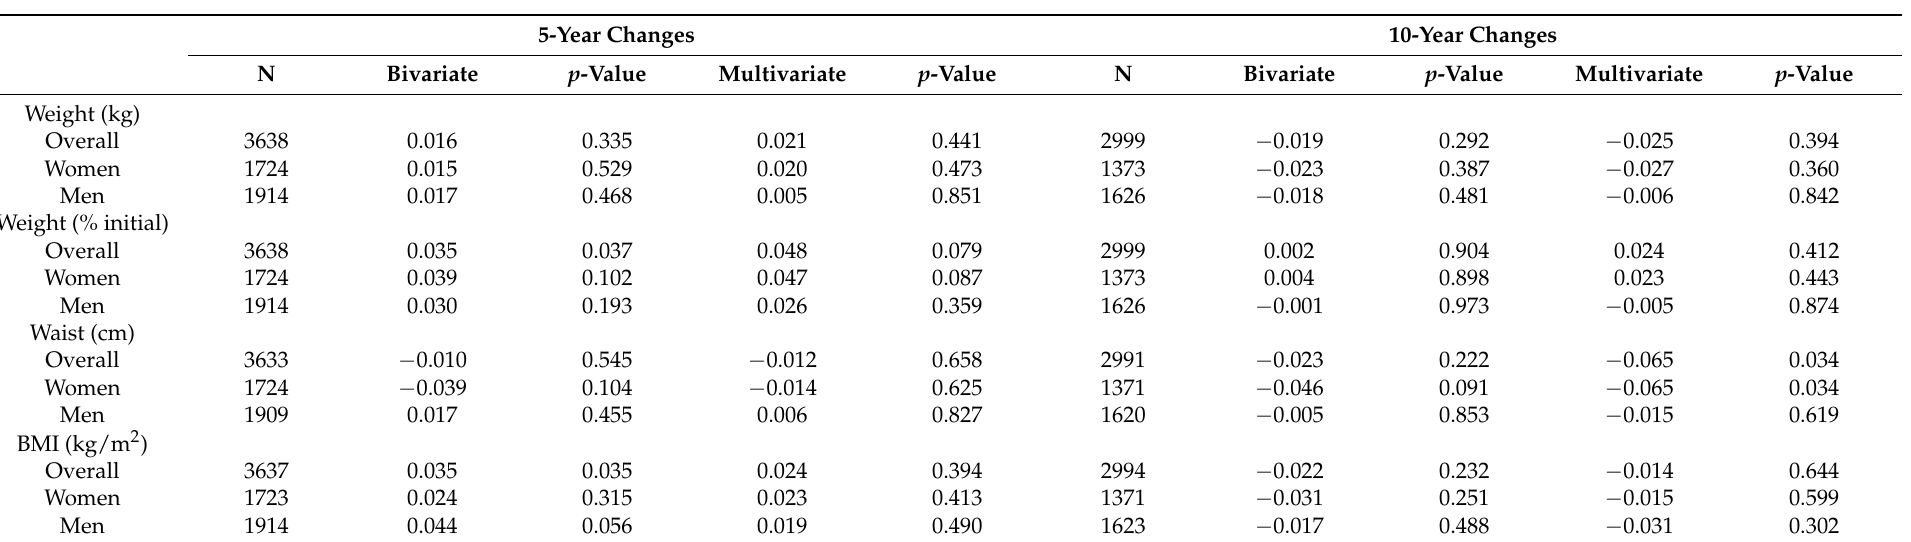
Table 3. Bivariate and multivariate associations between 5- and 10-year changes in weight, waist and body mass index according to baseline vitamin D levels, overall and by sex, CoLaus|PsyCoLaus study,